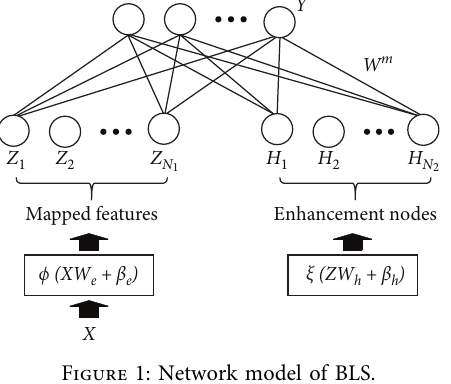
Figure 1: Network model of